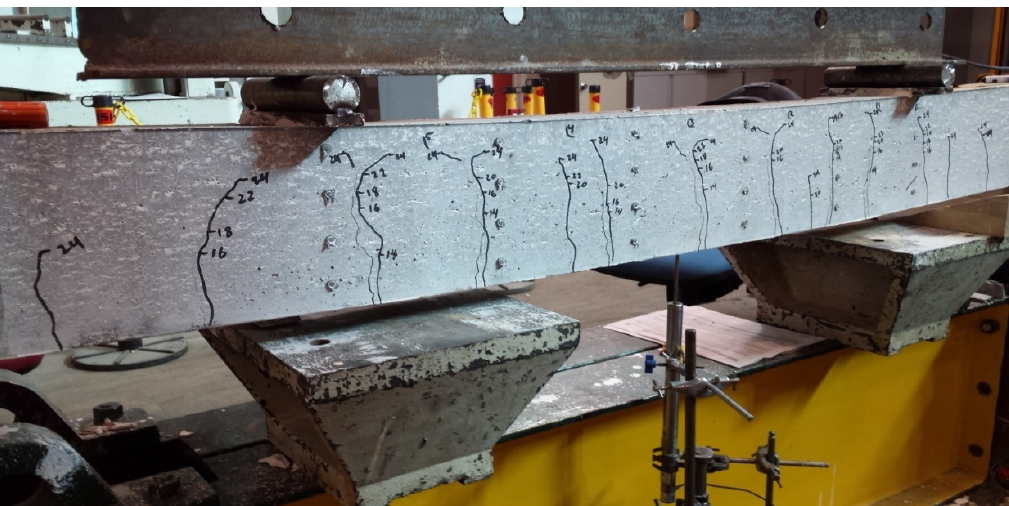
Figure 15. The failure mode and crack pattern of SRC beam.